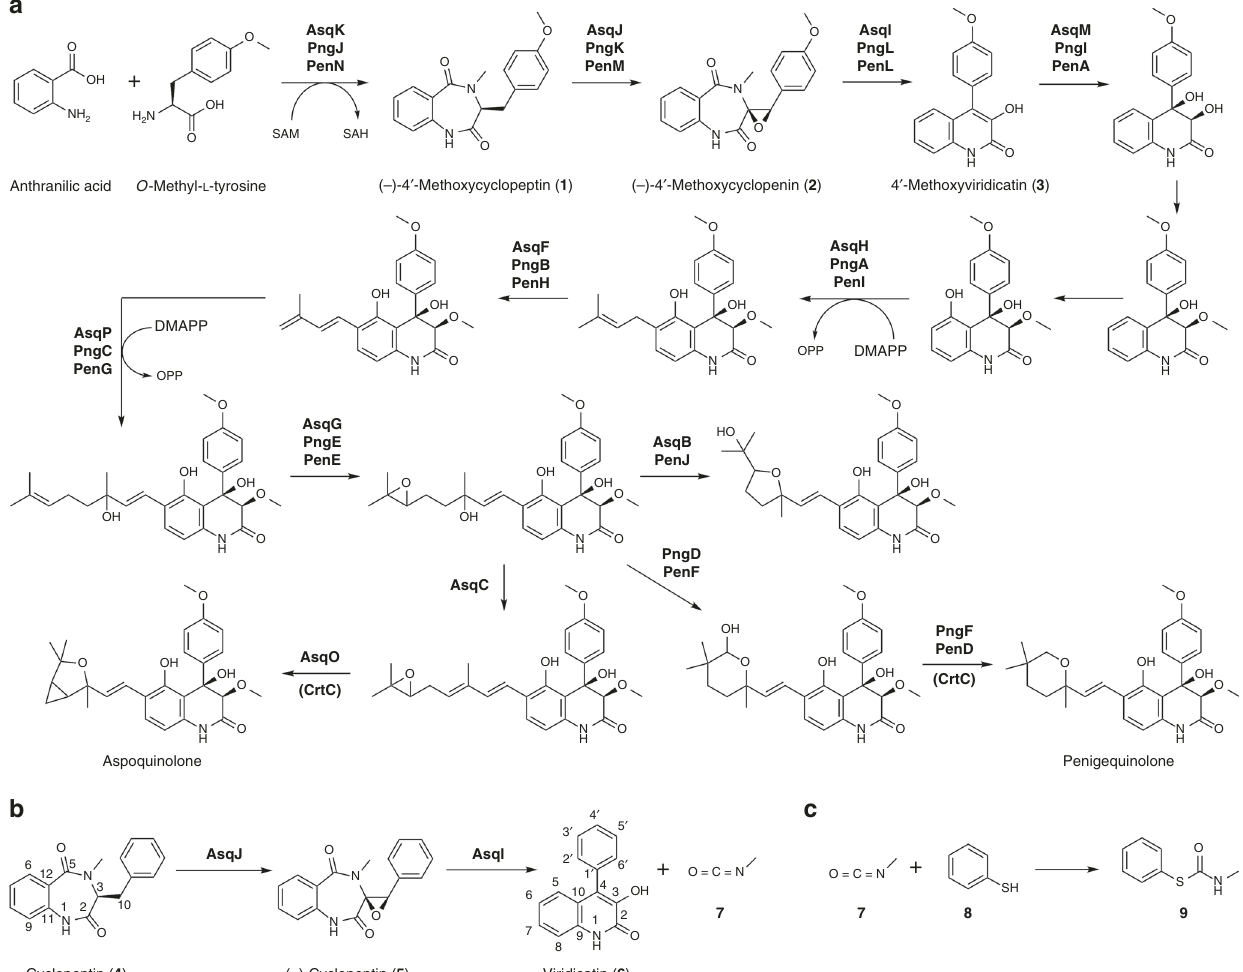
Fig. 1 Biosynthesis of viridicatin-type fungal alkaloids. a Proposed asq biosynthetic pathway in Aspergillus nidulans for the formation of aspoquinolone, and proposed pen / png biosynthetic pathway in Penicillium sp. for the formation of penigequinolone. b Proposed transformation of the non-4 ′ -methoxylated 6,7-bicyclic cyclopeptin 4 to 6,6-bicyclic viridicatin 6 . The non-heme dioxygenase AsqJ catalyzes the epoxidation of 4 to yield ( – )-cyclopenin 5 . Then, the hemocyanin-like AsqI catalyzes the ring contraction in 5 to form 6 via a 6 - endo - tet cyclization. c The product methyl isocyanate 7 was trapped by converting it to carbamothioate 9 with thiophenol 8 . DMAPP, dimethylallyl pyrophosphate; OPP,